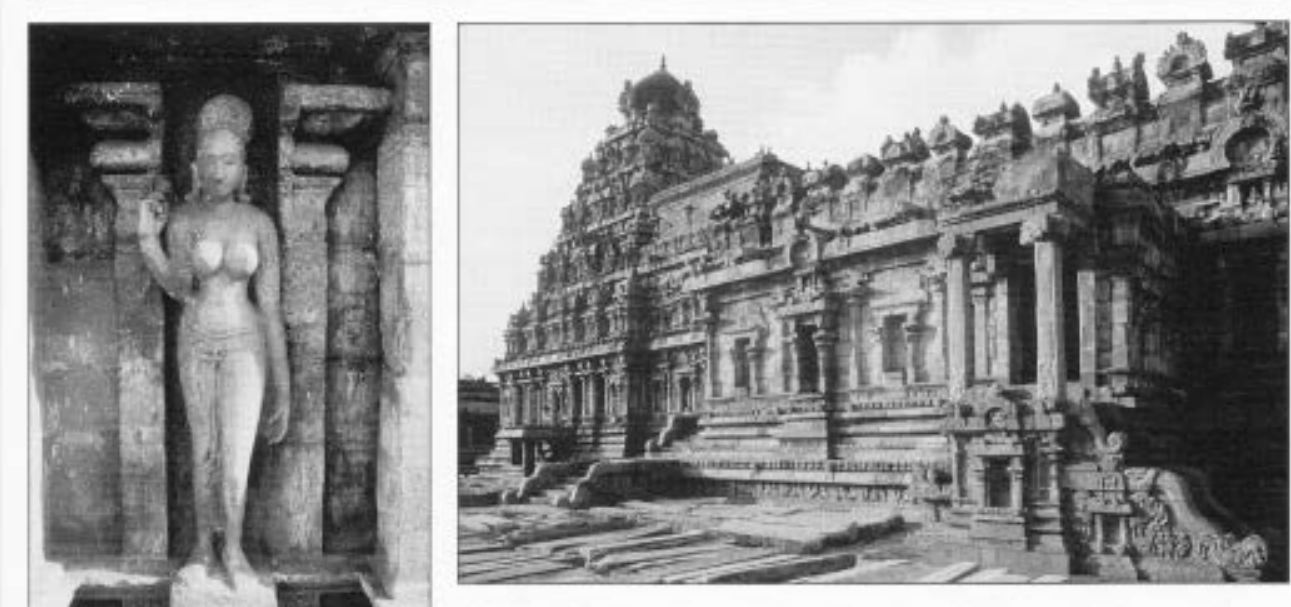
Figure 5 The Airavateshvara temple, Darasuram: view from the southeast showing the sanctum and pyramidal tower (vimana), and in the right foreground the southern porch leading up to the colonnaded hallway. Figure 4 The Nageshvara temple: sculp­ ture of a royal figure on the southern wall of the main sanctum.